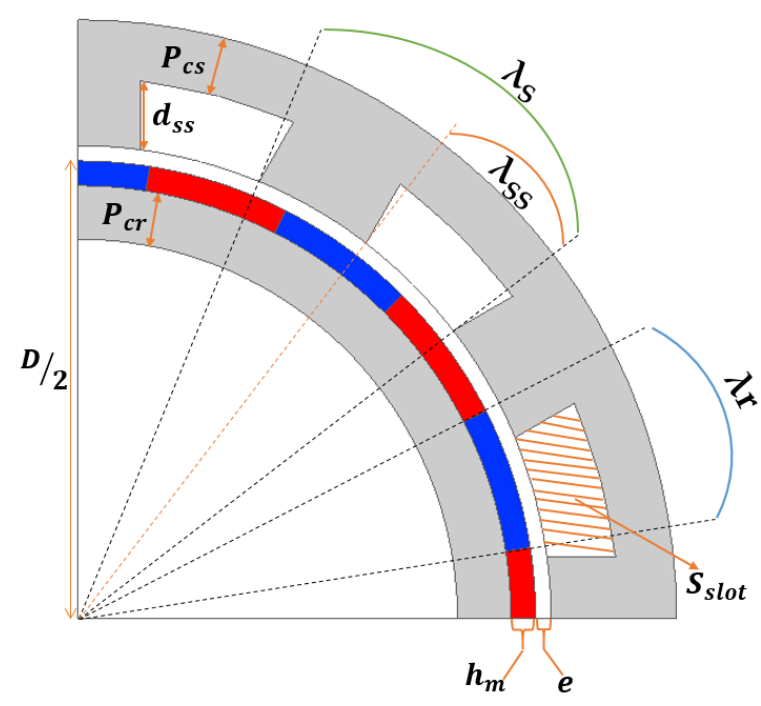
Figure 4. Definition of the main geometric parameters of PMVM structure.